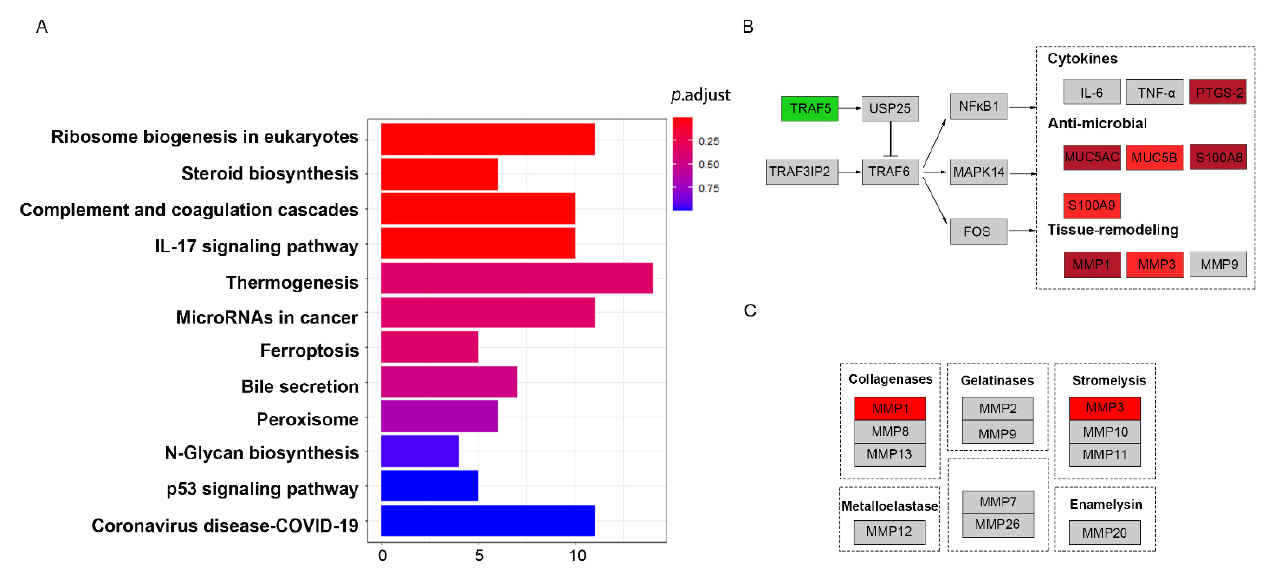
Figure 5. Pathway analysis of DEPs between RMC and RNMC. The identified proteins were indicated by colors in the pathway (upregulated in red, downregulated in green). ( A ) The DEPs enriched in the KEGG pathways. ( B ) The DEPs mapped to the IL-17 pathway. ( C ) The DEPs mapped to the matrix metalloproteinase signaling pathway.